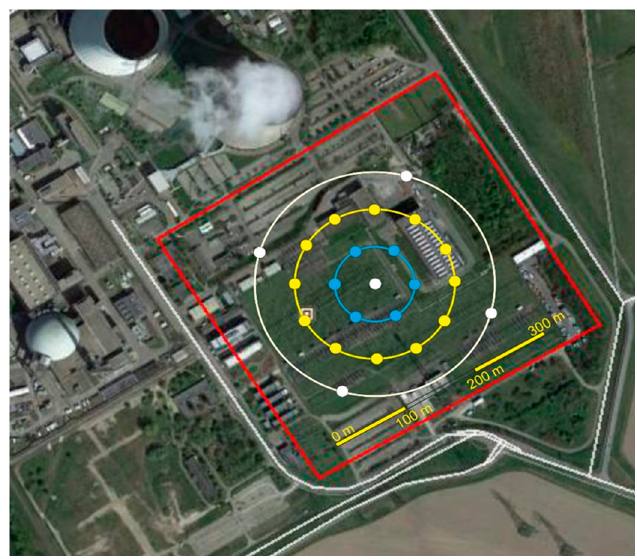
Figure 5. Cross section area for 18 boreholes including boreholes for monitoring (white).